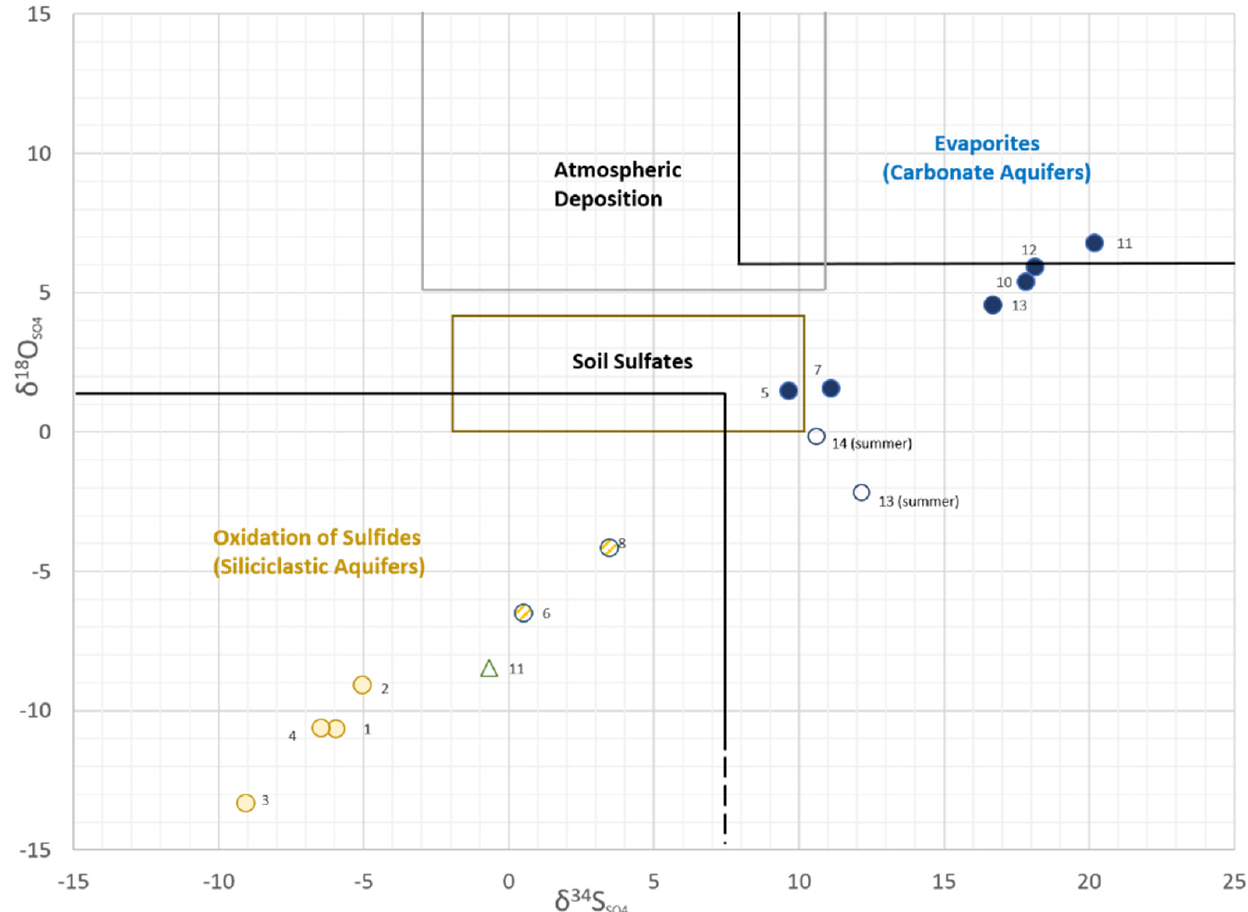
Figure 4. Cross plot of δ 18 O SO4 and δ 34 S SO4 for distance profile samples (filled circles and triangle). The isotopic composition of sulphate from samples collected in the open water season (July, 2017) at Elbow Falls and Little Elbow Main (open circles from Campbell et al. [16]) are included to show seasonal differences occur but do diverge from the two-end-member mixing line. The origin of SO 4 indicated by the range of isotopic values are shown by boxed areas (adapted from Krouse and Mayer, 2000). Symbol colours indicate relative contribution from rock–water interaction in two end-member aquifers (yellow—siliciclastic; blue—carbonate; hatched yellow—intermediate or mixed).